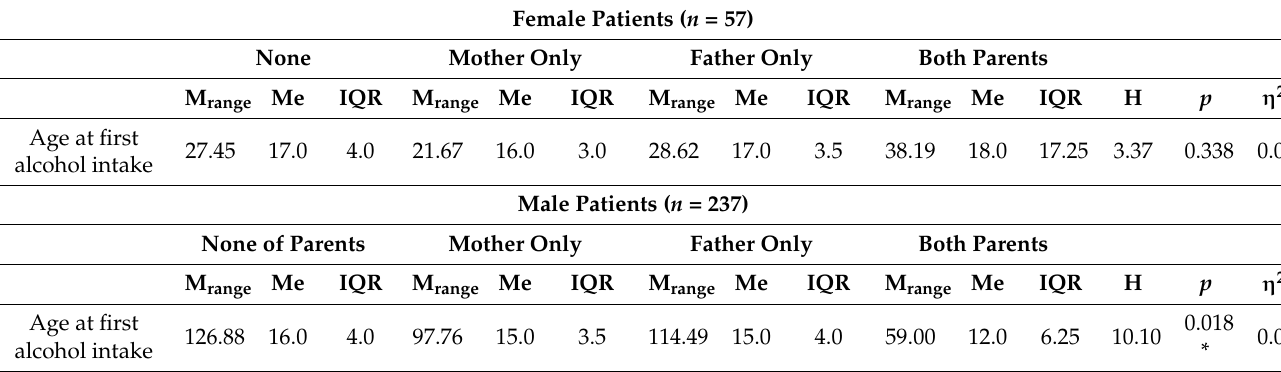
Table 3. Comparison of age at first alcohol intake in female and male patients with alcohol dependence reporting a parental history of alcohol